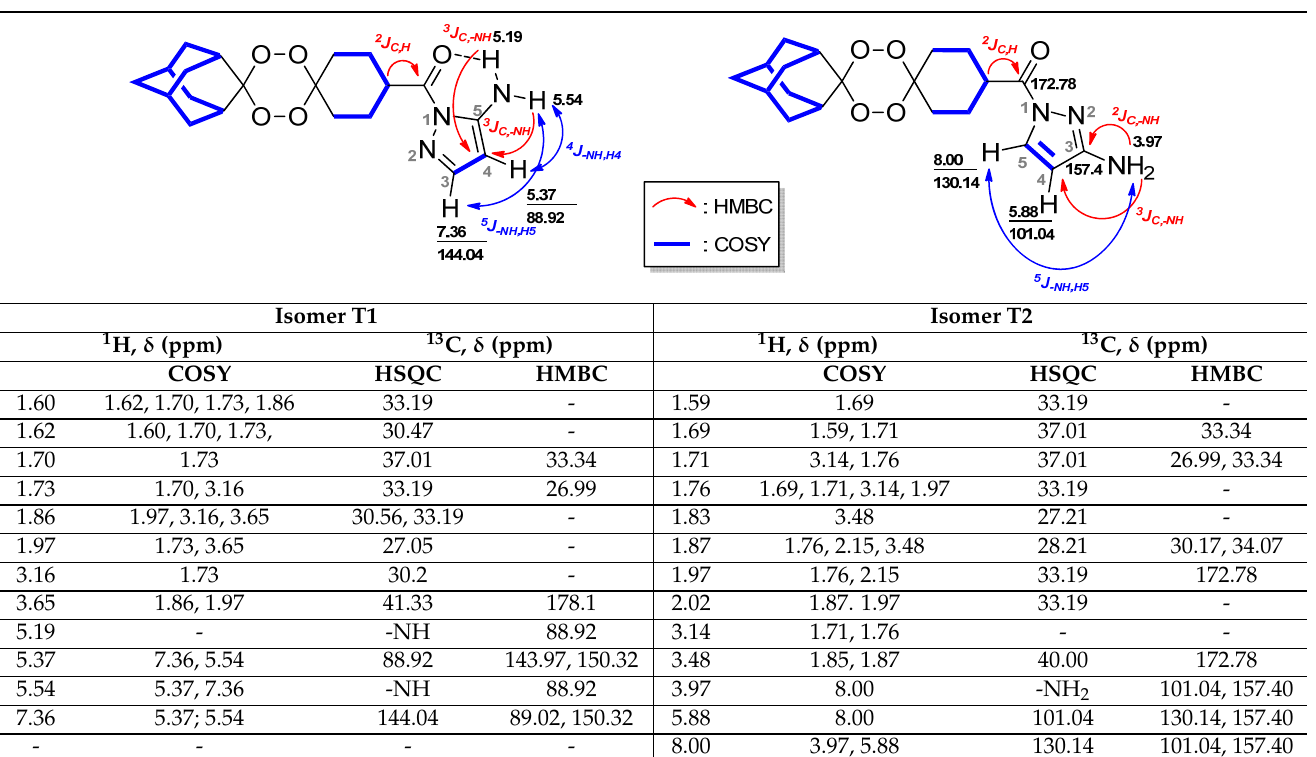
Table 2. Correlations found in the HSQC, and HMBC spectra of 1,2,4,5-tetraoxane–pyrazole isomers T1 and T2 .